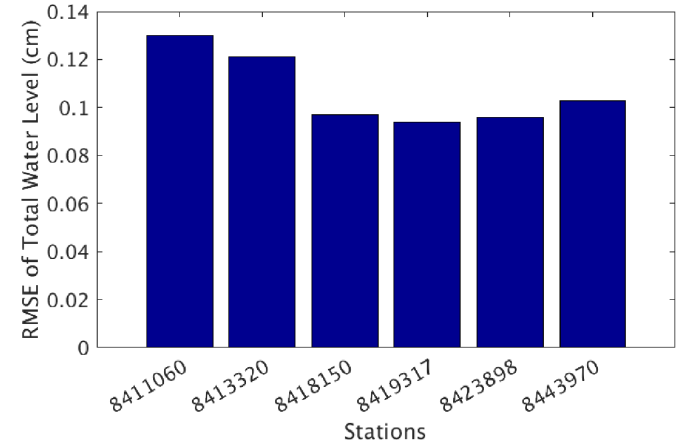
Figure 9. RMSE of the modeled water level.